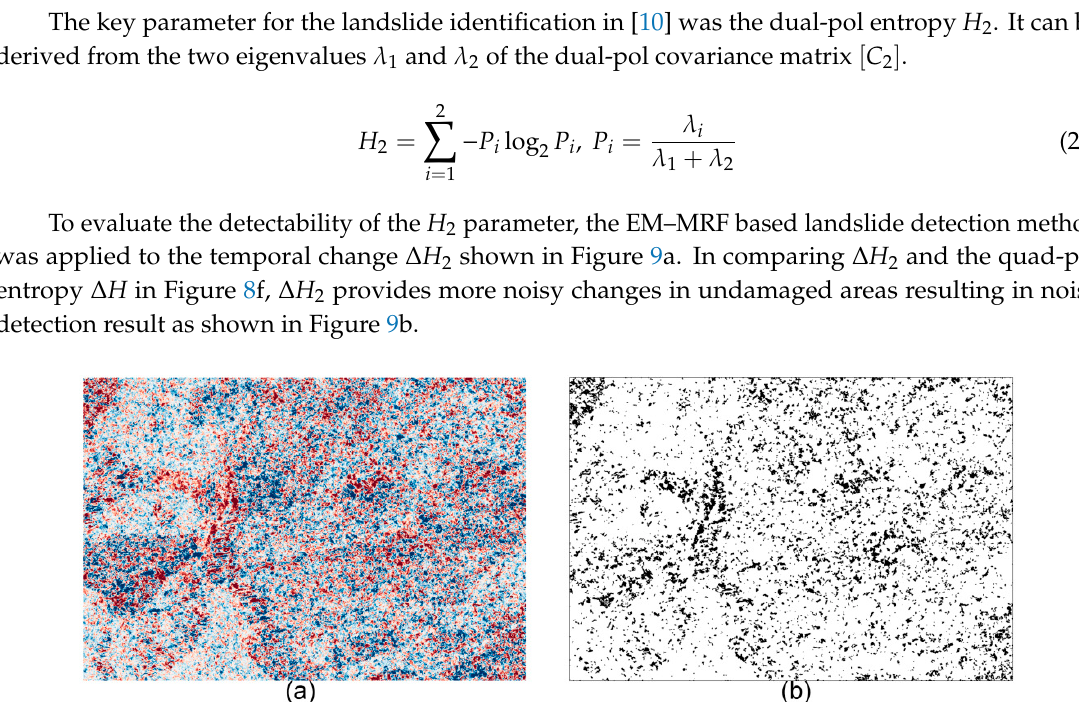
Figure 9. ( a ) The difference images of the dual-pol entropy and ( b ) the landslide detection result.